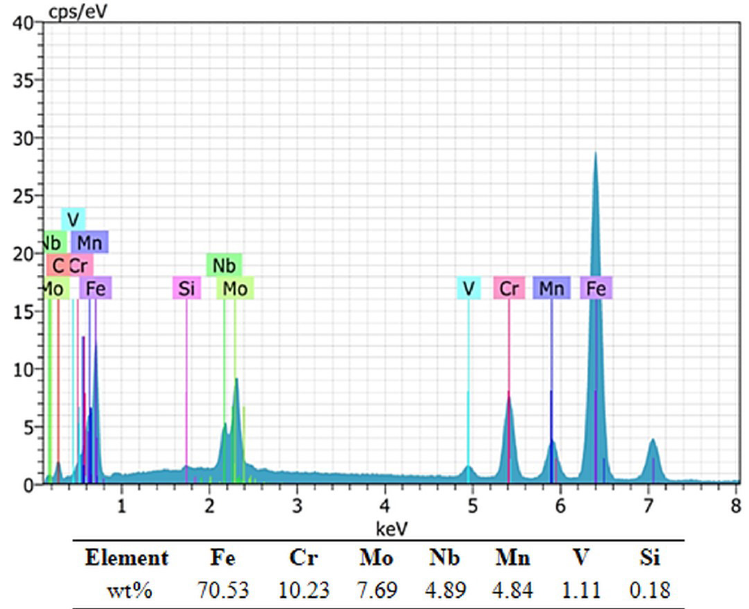
Figure 5. Spectrogram of X22CrMoV12-1 alloy in point